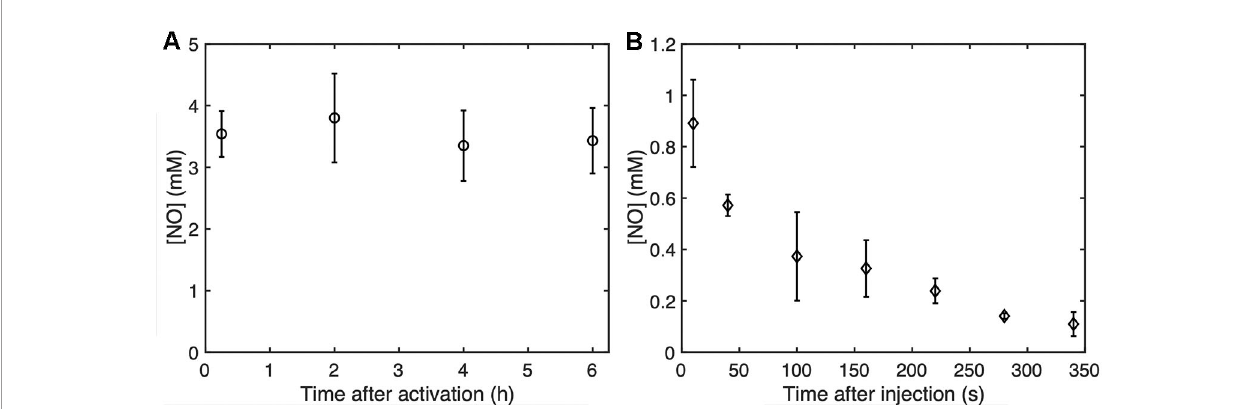
FIGURE 10 | (A) The “ in vial ” concentration of NO-OFP-MB 9:1 v/v measured up to 6 hours after activation. (B) The NO concentration as a function of time up to 340 s after the addition of NO-OFP-MB 9:1 v/v in the 96 well-plate. The mean ± 1 standard deviation is depicted (n = 3 measurements for each time point). NO- OFP-MB, Nitric oxide and octa fl uoropropane microbubbles.